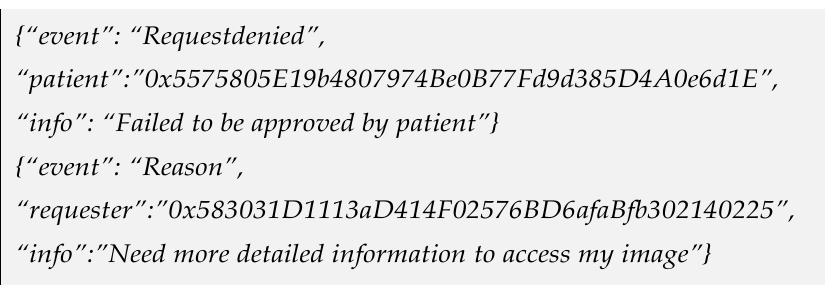
Figure 7. Case 2: event log stored in the blockchain for denying access to IR 2 address.